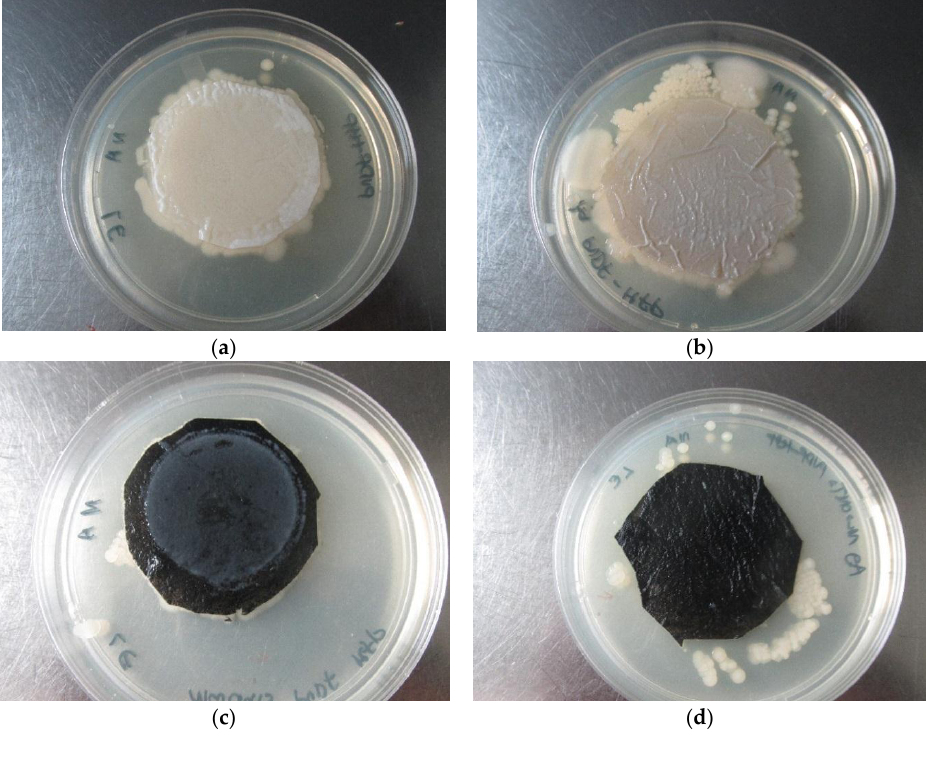
Figure 9. Evaluation of antibacterial activity of ( a ) PVDF-HFP, ( b ) Ag/PVDF-HFP, ( c ) MWCNTs-PVDF-HFP ( d ) Ag-MWCNTs-PVDF-HFP.